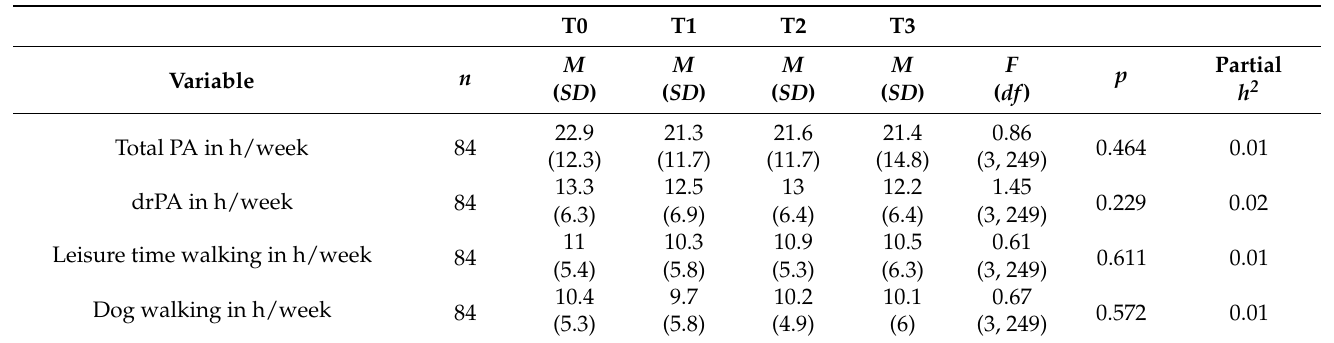
Table 7. Changes in PA and walking behavior of participants who completed the